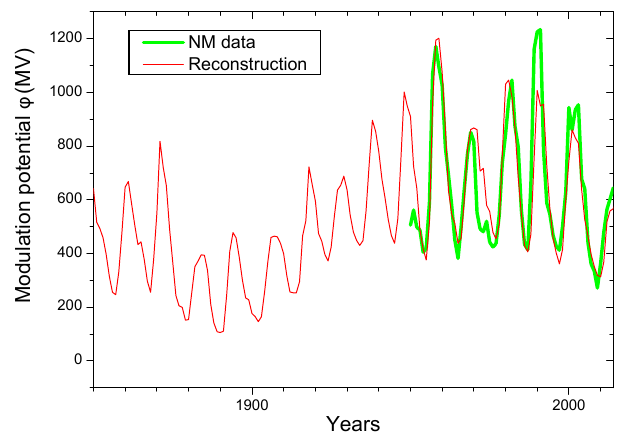
Figure 19. Time series of the reconstructed heliospheric modula- tion potential φ including solar-cycle variations. The thick green line is the modulation potential reconstructed for the period 1951– 2014 using data from the worldwide neutron monitor (NM) network (Usoskin et al.,